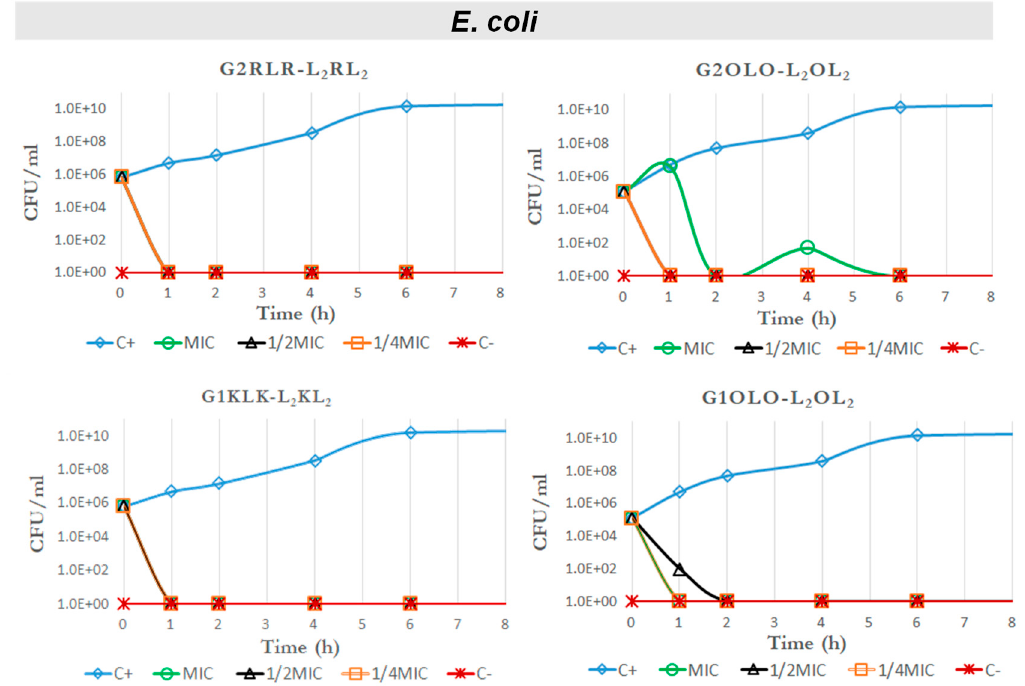
Figure 5. Time–kill curves against E. coli for G2RLR-L 2 RL 2 , G2OLO-L 2 OL 2 , G1KLK-L 2 KL 2 and G1OLO-L 2 OL 2 .